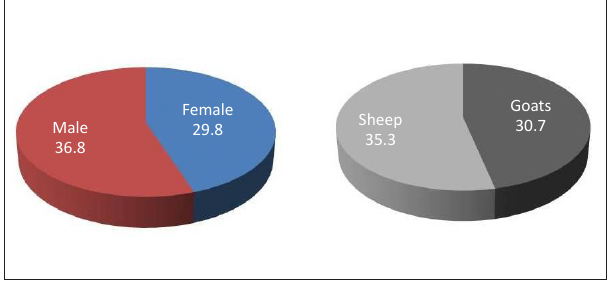
FIGURE 3: Proportions ( % ) for seroprevalence by sex (left) and species (right).